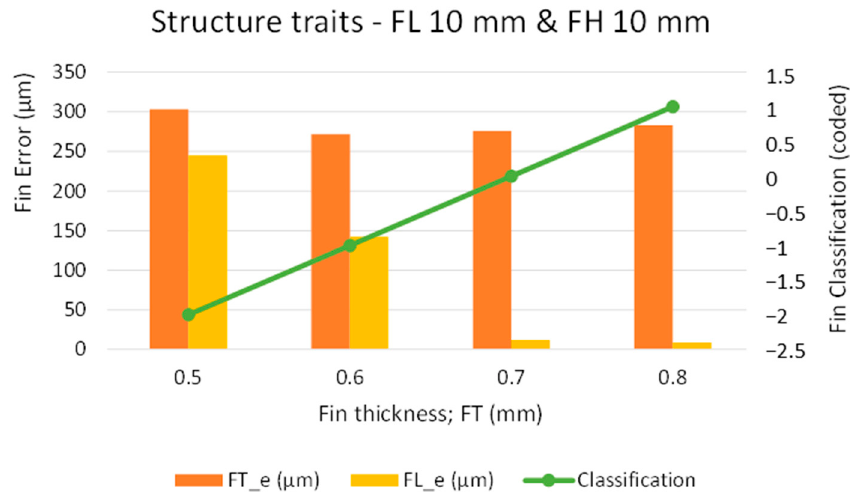
Figure 11. Graphical analysis of structure traits in the third phase of experimentation.